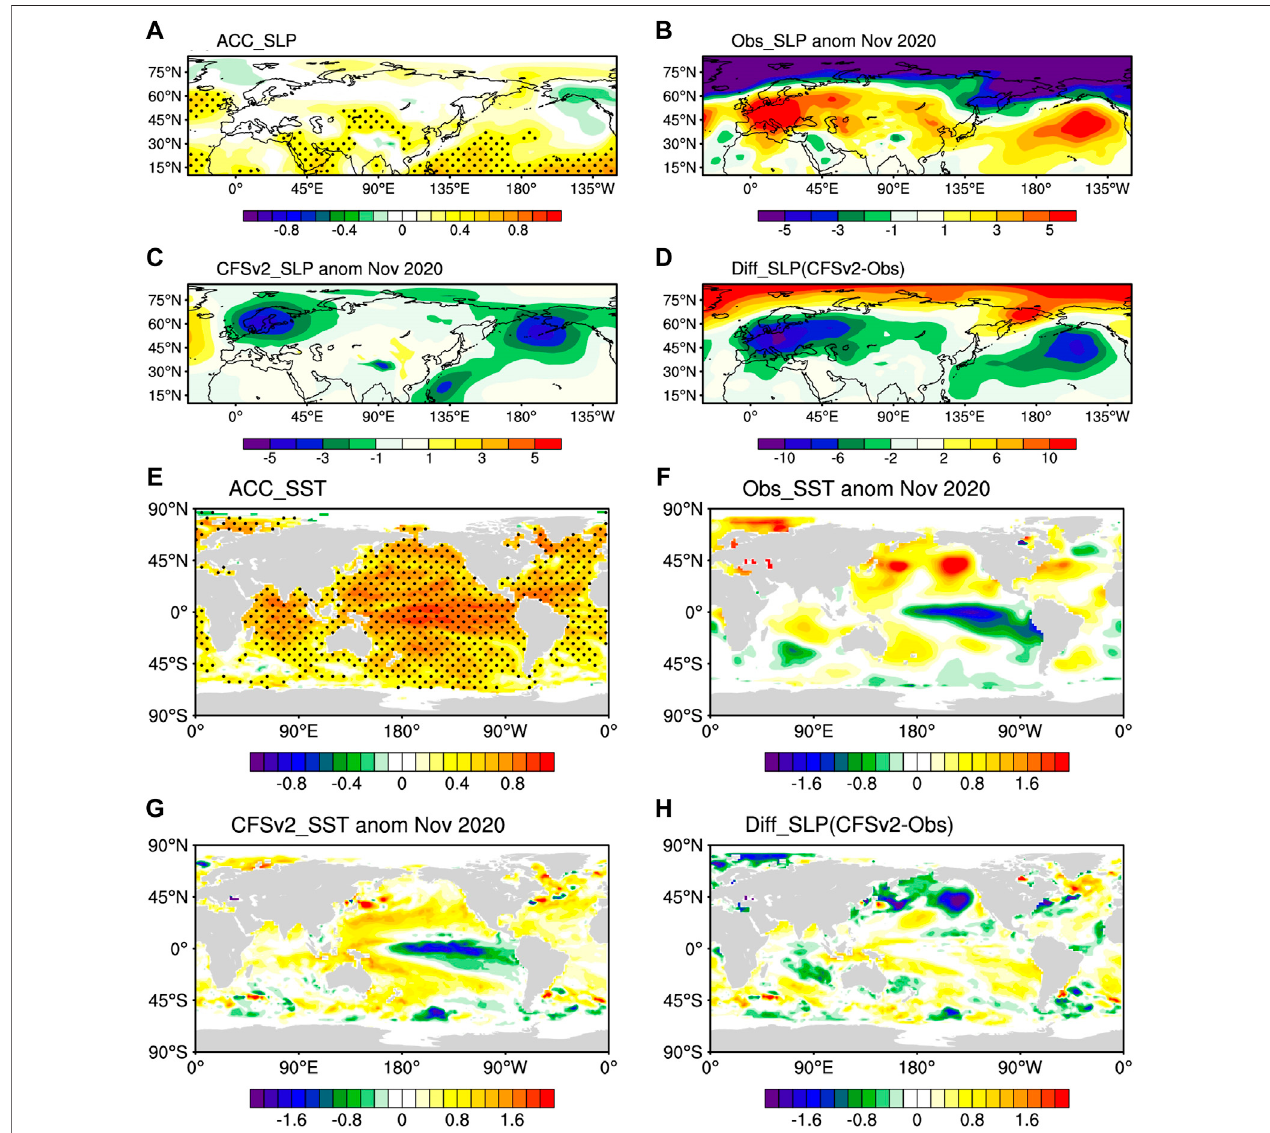
FIGURE13 | (A) Correlation coef fi cient between observations and theone-month-lead forecast during 1982 – 2020. (B,C) The anomalous SLP (unit: hPa) from (B) observations and (C) the one-month-lead forecast of CFSv2 in November 2020. (D) Difference between the one-month-lead forecast and observations. (E – H) As in (A – D) but for the anomalous SST (unit: ° C) fi elds. Regions above the 90% signi fi cance level are